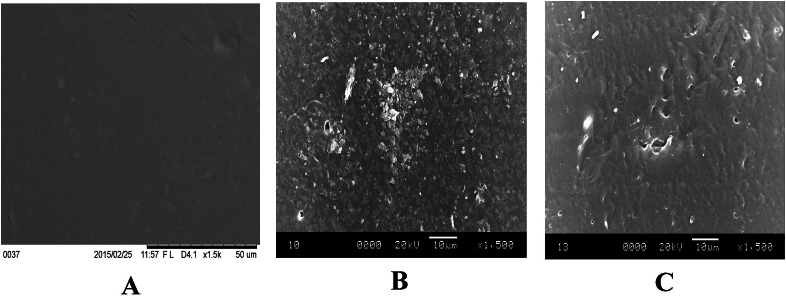
Representative SEM micrographs of untreated and HNO3 treated mPE.(A) Untreated mPE (B) 30 min HNO3 treated mPE (C) 60 min HNO3 treated mPE.